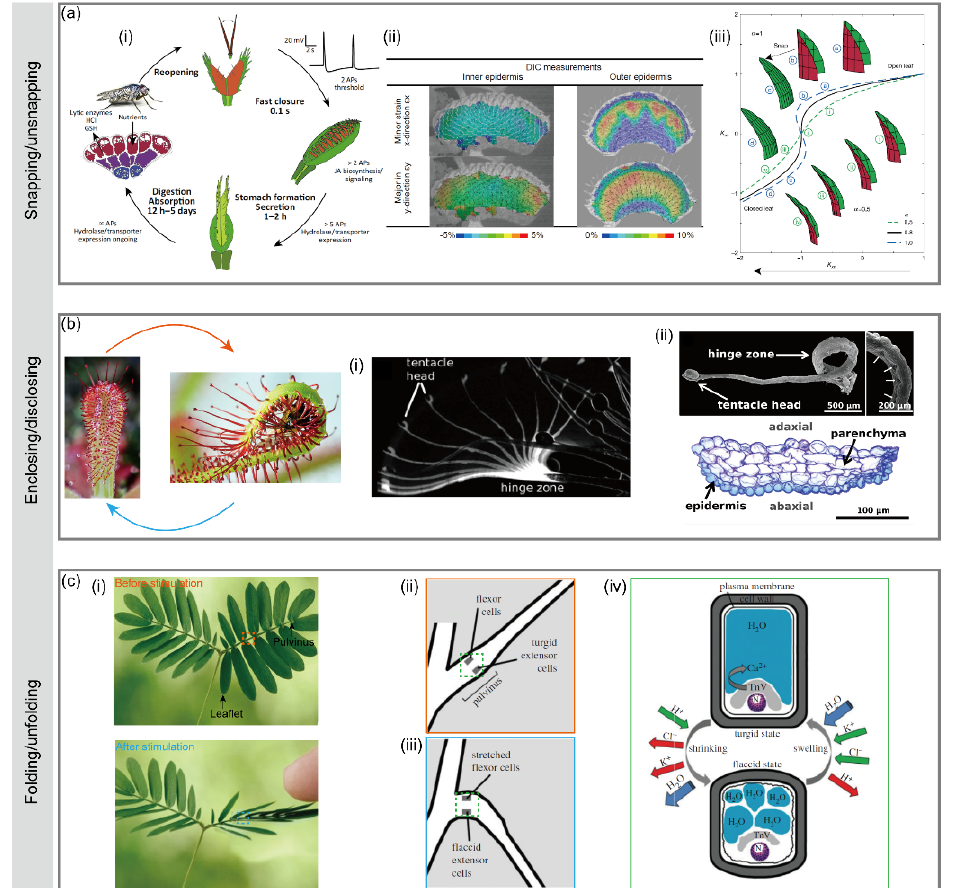
Figure 3. Thigmonastic movements in plants and actuation mechanisms. ( a ) Snapping/unsnapping of Venus flytrap (reproduced with permission from References [12,43,47]). ( b ) Enclosing/disclosing of sundew tentacles (reproduced with permission from Reference [52]). ( c ) Folding/unfolding of mimosa leaflets (reproduced with permission from Reference [53]).